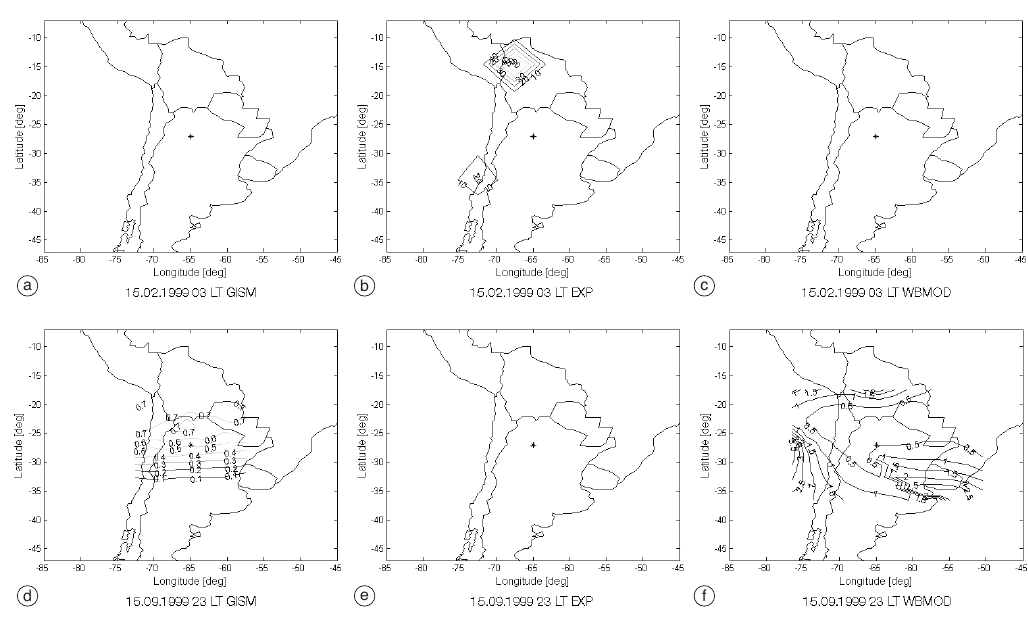
Fig. 7a-f. Percentages of occurrence of S 4 > 0.5 for experimental data and WBMOD and predicted S 4 values by GISM are shown at 03 LT during 15.02.1999 and 23 LT during